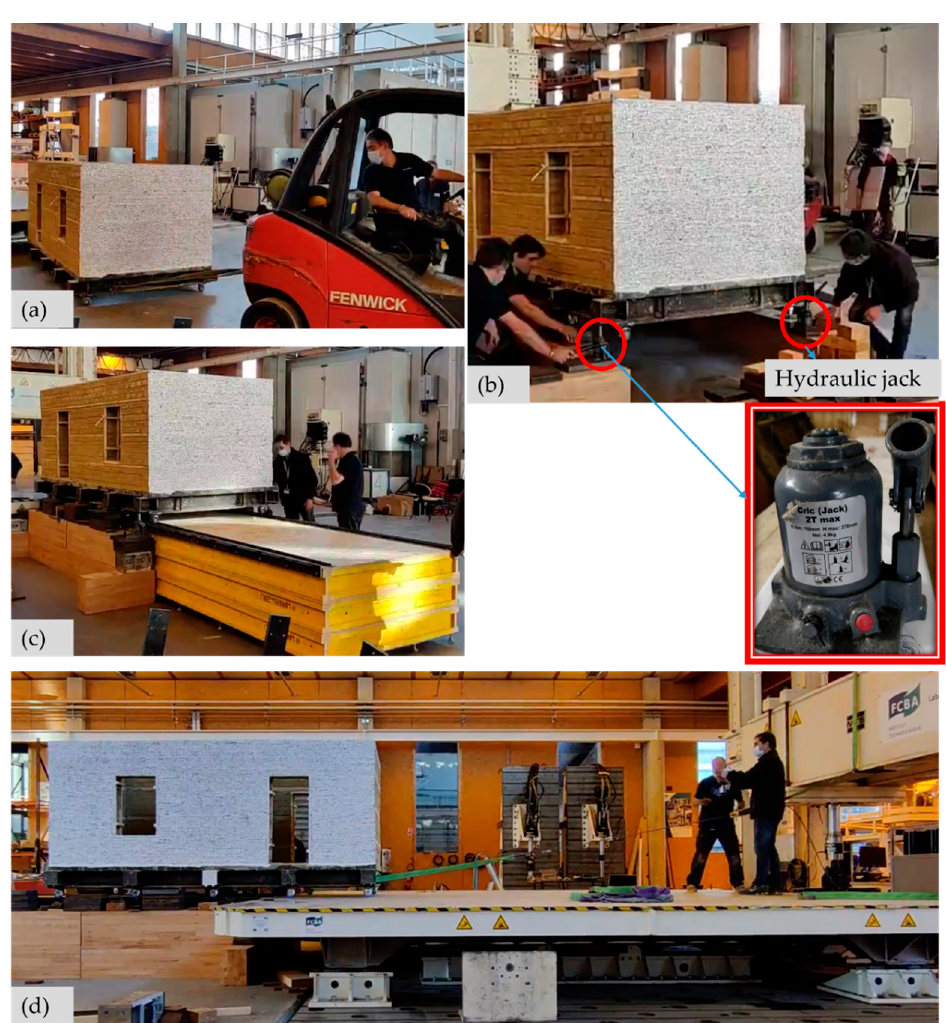
as shown in Figure 7b.